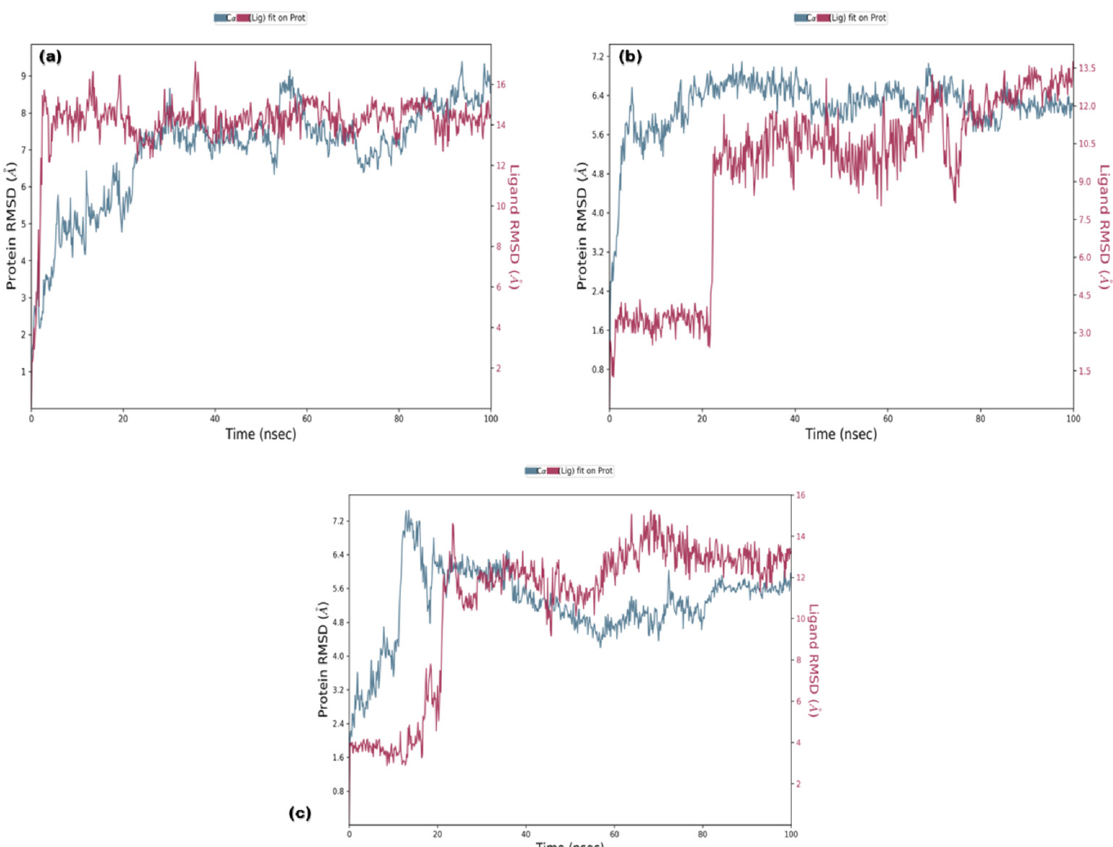
Figure 5. Root mean square deviation plots of docked complexes (( a ) secoisolariciresinol, ( b ) syringaresinol and ( c ) cleomiscosin A) representing protein evolution ( y -axis) during 100 ns MD simulations.